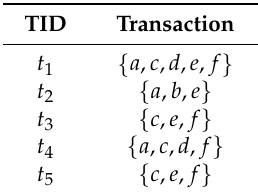
Table 2. D Example. TID = transaction